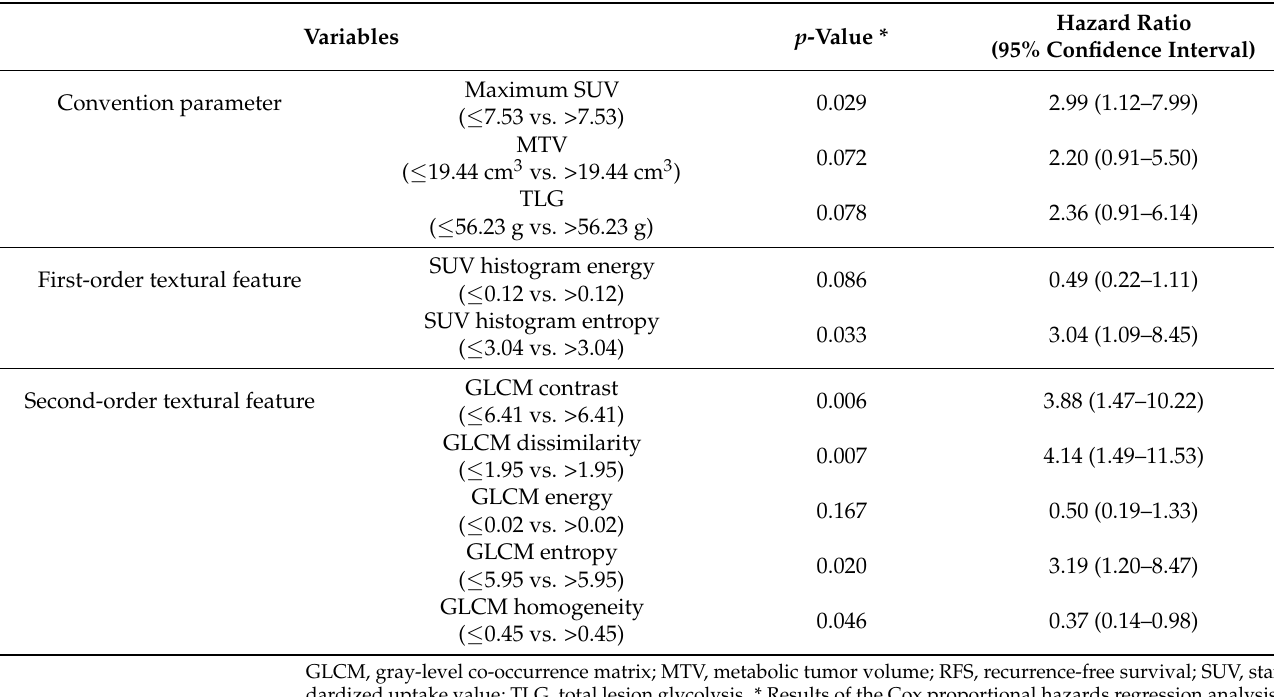
Table 4. Multivariate analysis of textural features for predicting RFS after adjustment for age, sex, and TNM stage.